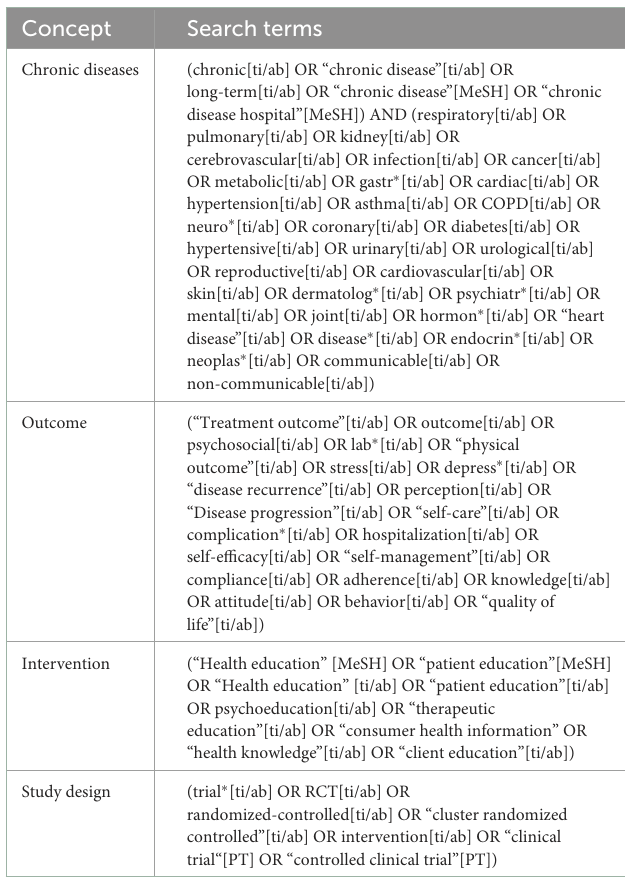
TABLE 1 Search strategy adapted for PubMed